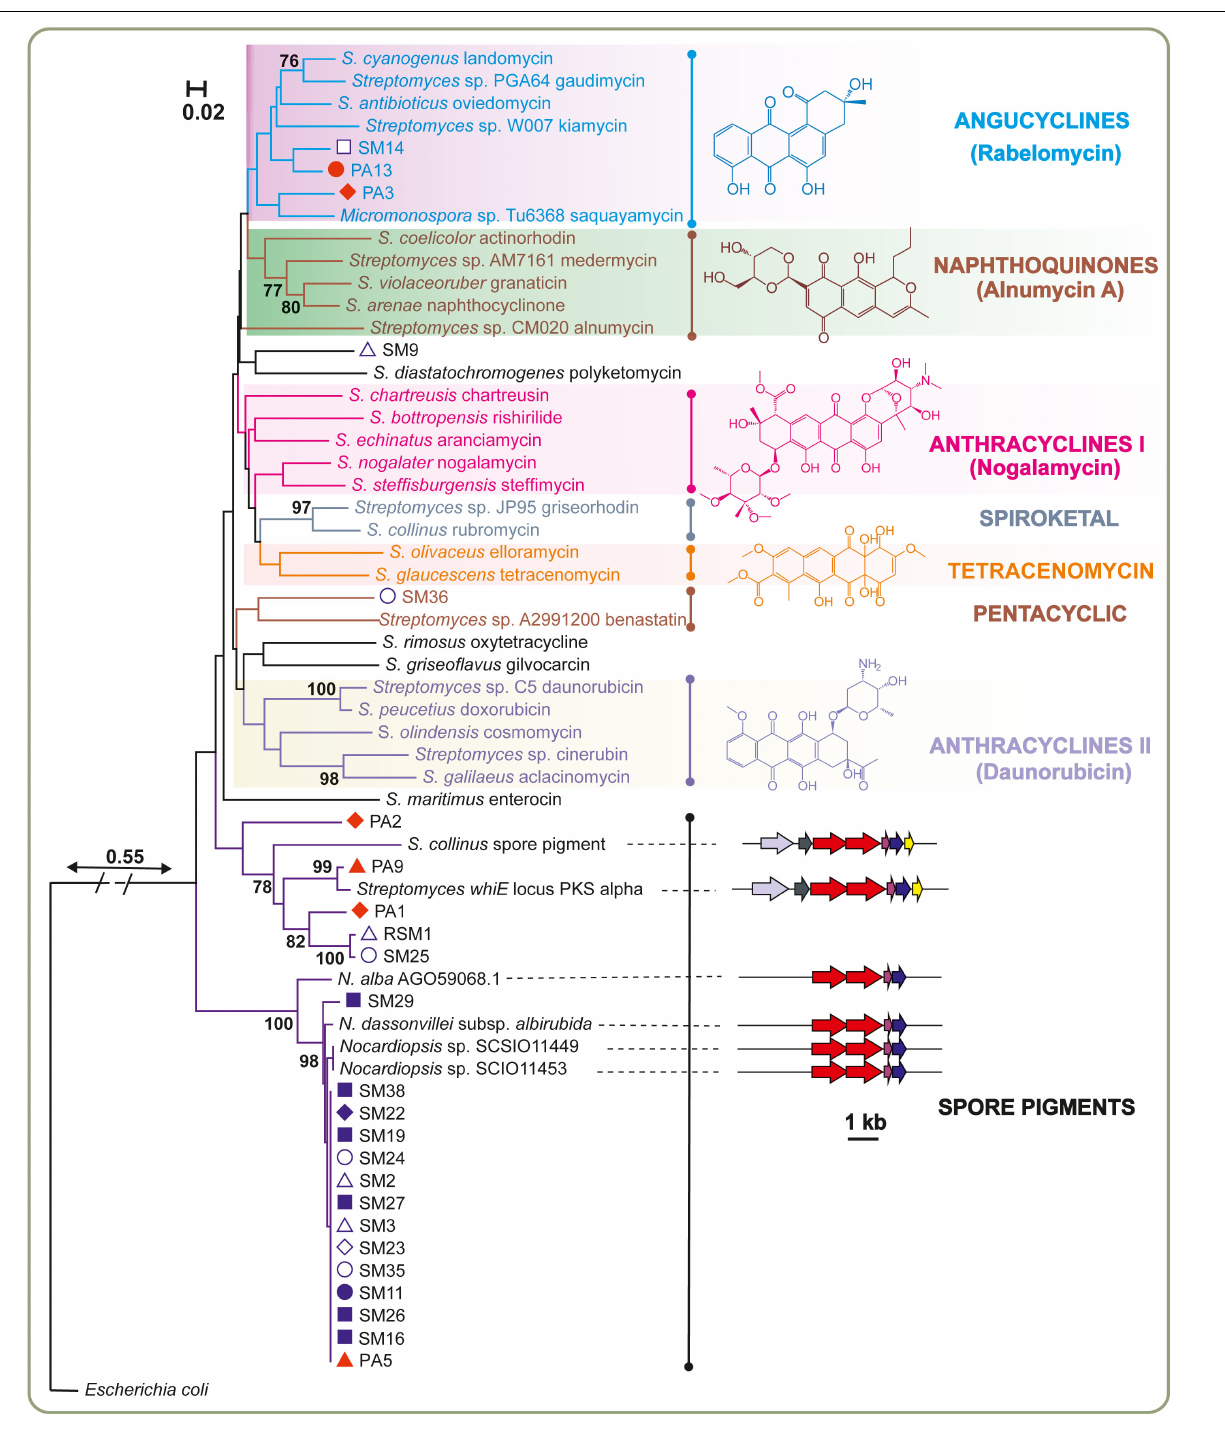
FIGURE 4 | Genotyping the potential of sponge-associated Actinobacteria for production of aromatic polyketides. The neighbor-joining tree was constructed using aligned KS α domain amino acid sequences. Next to the KS α gene name, the identified or predicted compounds of the gene cluster are indicated. Bootstrap values calculated from 1000 replicates are shown at the respective nodes when the calculated values were 75% or greater. The scale bar represents 0.02 substitutions per amino acid position. The red and blue symbols adjacent to the analyzed bacterial strains correspond to sponge host ( Figure 1 ). The boundary between spore pigment and antibiotic biosynthesis sequences was assessed based on additional analysis of gene cluster contents. Verified spore pigment gene clusters from Streptomyces displayed similarity and synteny to unknown biosynthetic gene clusters from Nocardiopsis type strains with conservation of ketosynthases (red), acyl carrier proteins (pink) and cyclases